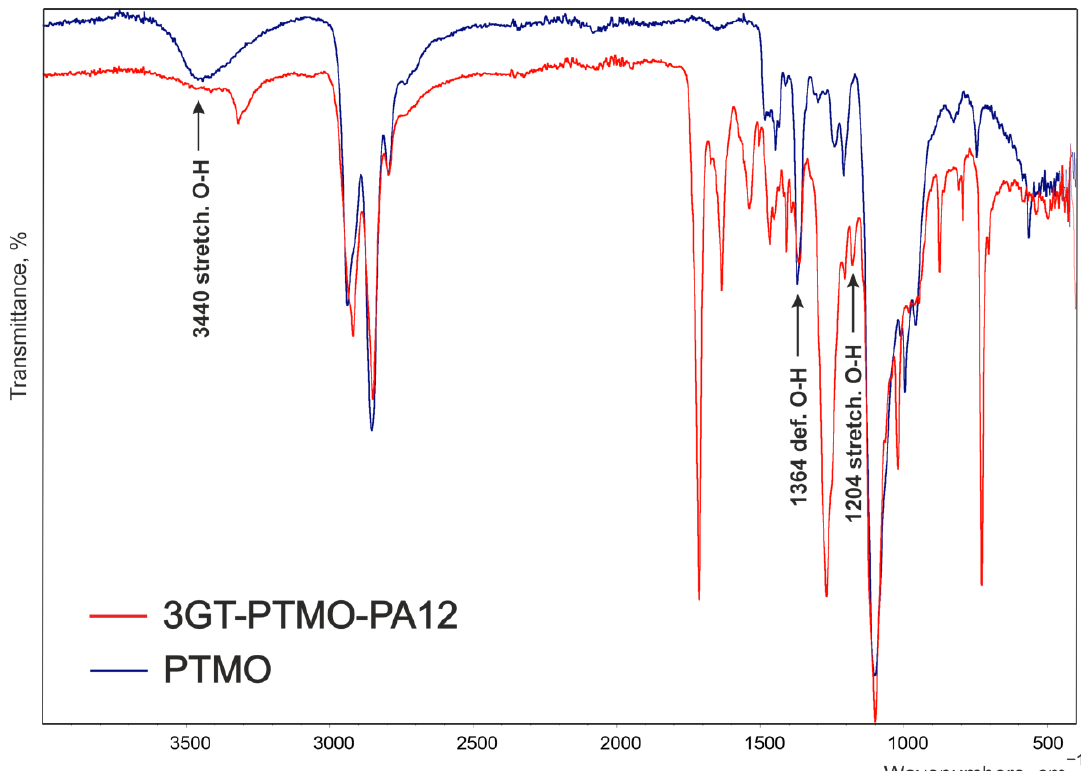
Figure 5. FT-IR spectrum of the reference terpolymer (3GT-PTMO-PA12) and PA12 homopolymer.